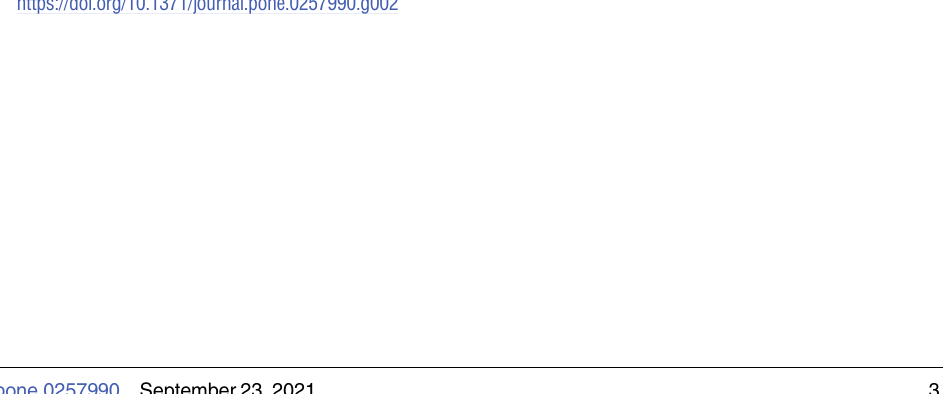
PLOS ONE | https://doi.org/10.1371/journal.pone.0257990 September 23,